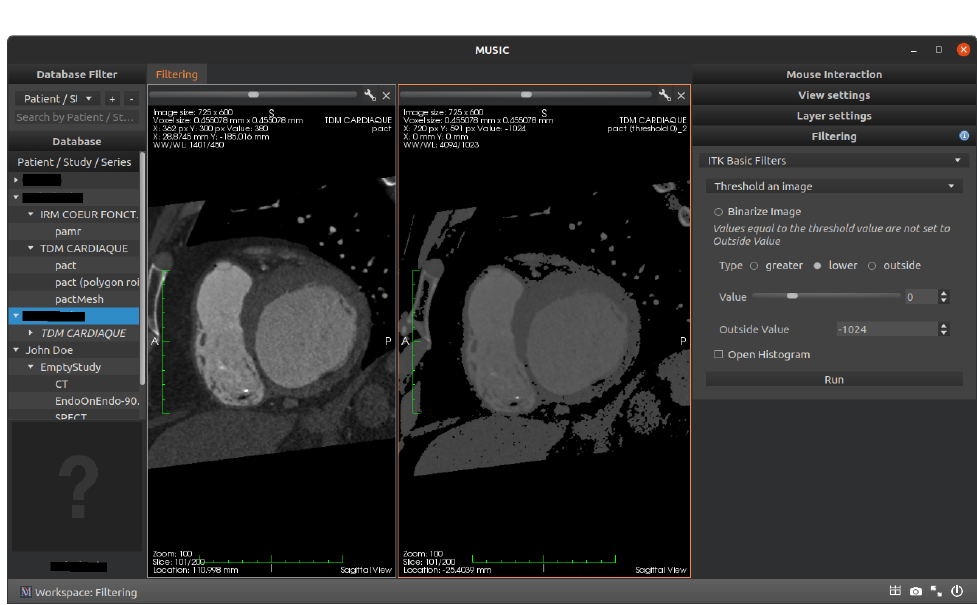
Figure 4. Example of the thresholding of CT